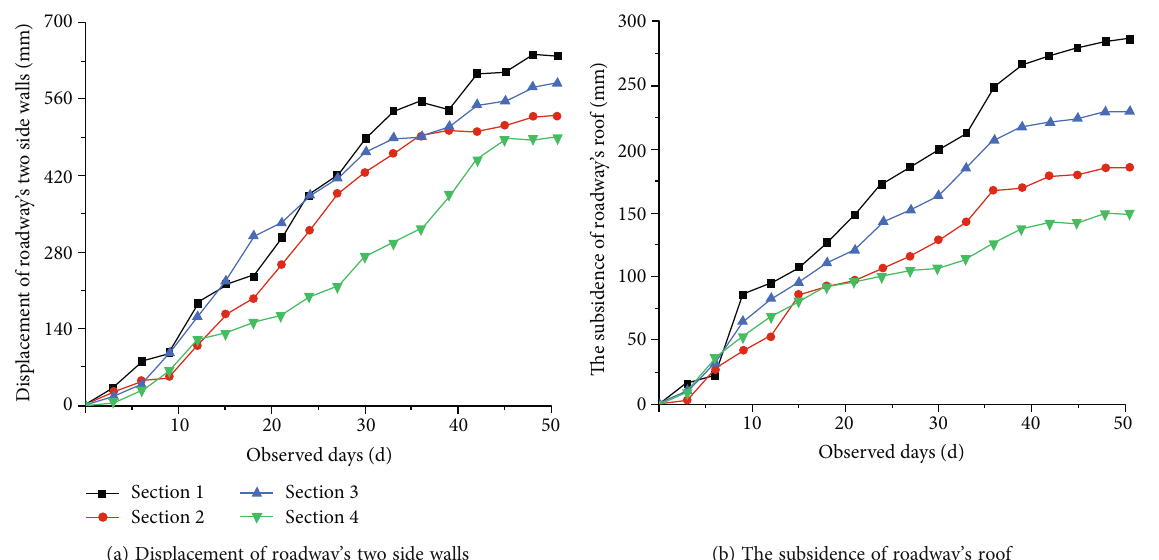
Figure 14: Roadway surface displacement monitoring